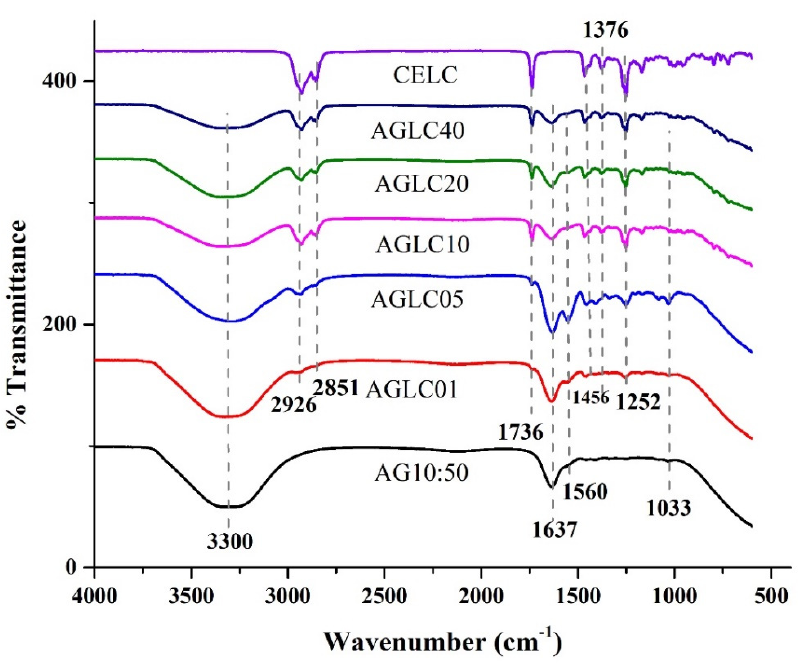
Figure 6. FTIR spectra of AGLC bioinks.